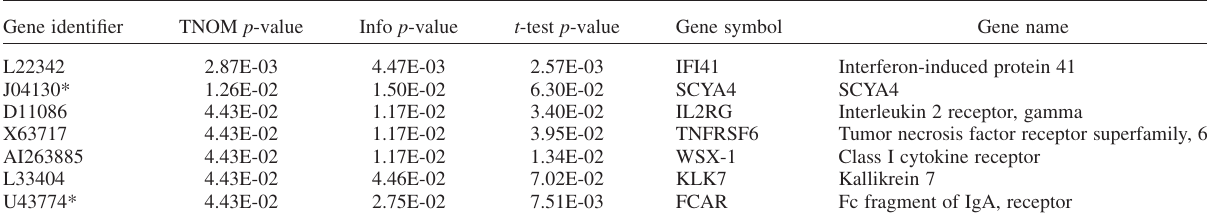
TABLE II List of seven cytokine-related gene transcripts in the MS treatment